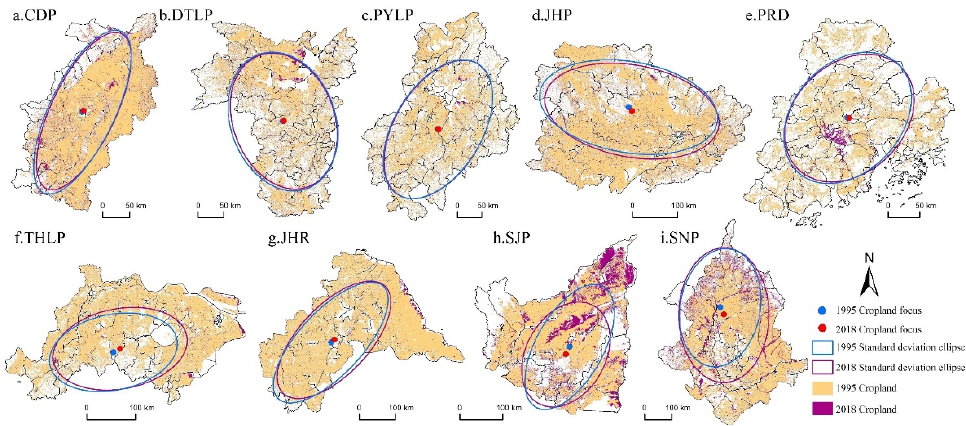
Figure 4. Standard deviation ellipses of cropland, 1995–2018.